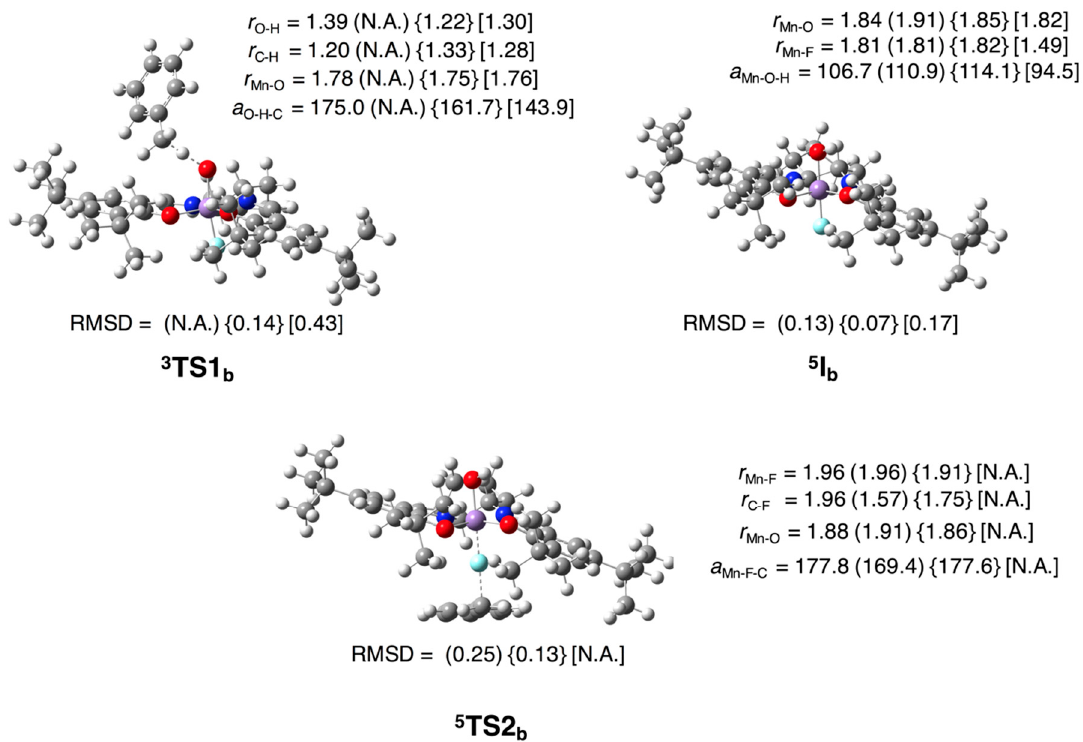
Figure 5. Selected optimized structural parameters of critical points in the epoxidation reaction of ethylene catalyzed by 3 [F–Mn V =O(salen)], with bond lengths (in Å) and angles (in deg.) obtained at the UB3LYP/SVP, UPM6, UrPM6, and UPM7 levels of theory, and with heavy-atom root-mean- squared deviation (RMSD) values from the reference UB3LYP-optimized structures. Only 5 [F–